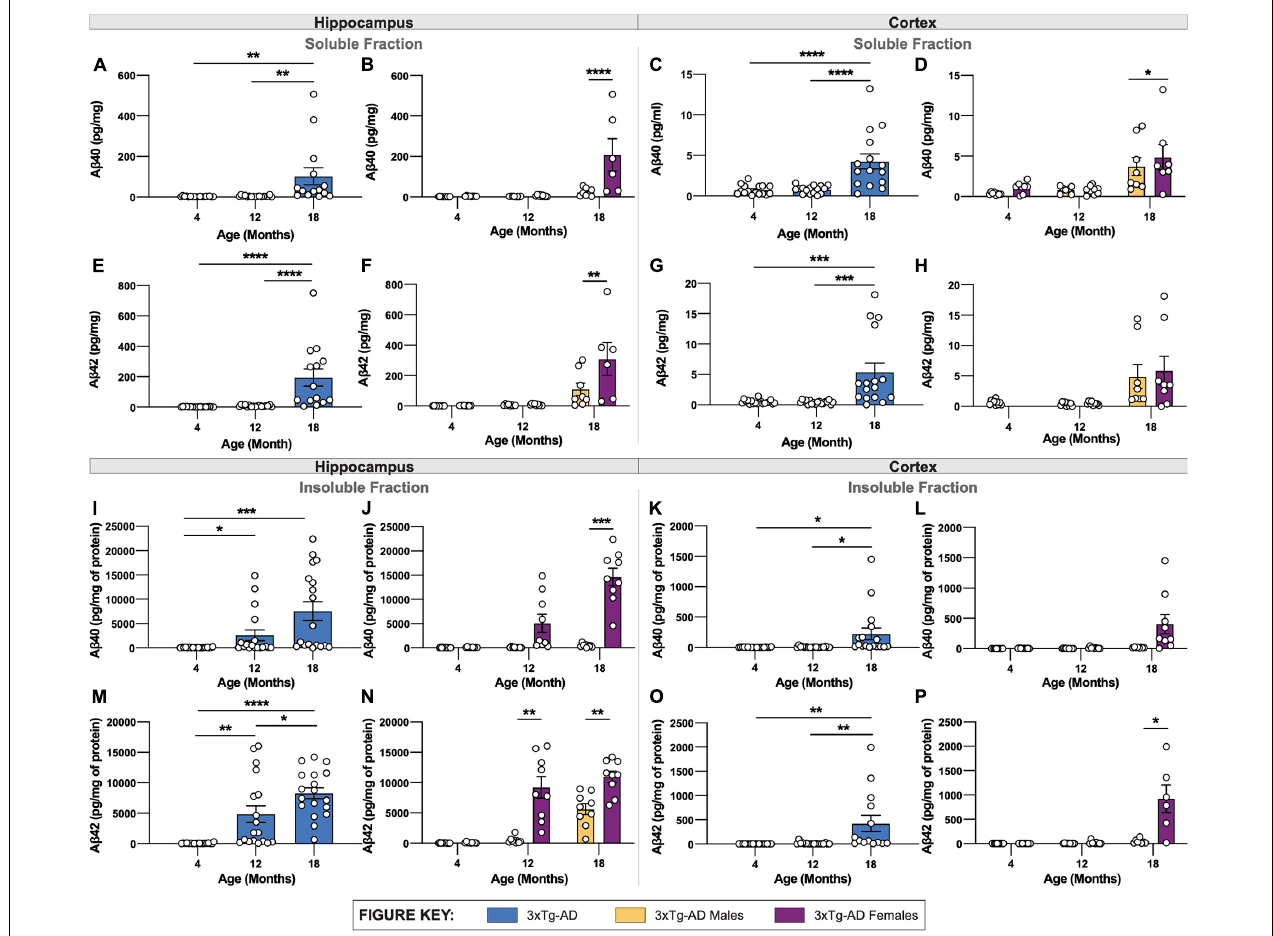
FIGURE 3 | Quantification of A β isoforms in 3xTg-AD mice of different age and sex. A β was quantified in micro-dissected hippocampi and cortices via Mesoscale Multiplex technology. (A–H) A β 40 and A β 42 were measured in the soluble fraction of hippocampus (A,B,E,F) and cortex (C,D,G,H) , respectively, with age-related increases in A β 40 and A β 42 shown in hippocampus and cortex of 3xTg-AD mice between sexes. (I–P) An age-related increase in insoluble A β 40 and A β 42 was also observed in hippocampus (I,J,M,N) and cortex (K,L,O,P) of 3xTg-AD mice between sexes. n = 5–6 mice per genotype/age/sex. Data are represented as mean ± SEM. * p ≤ 0.05, ** p ≤ 0.01, *** p ≤ 0.001, **** p ≤